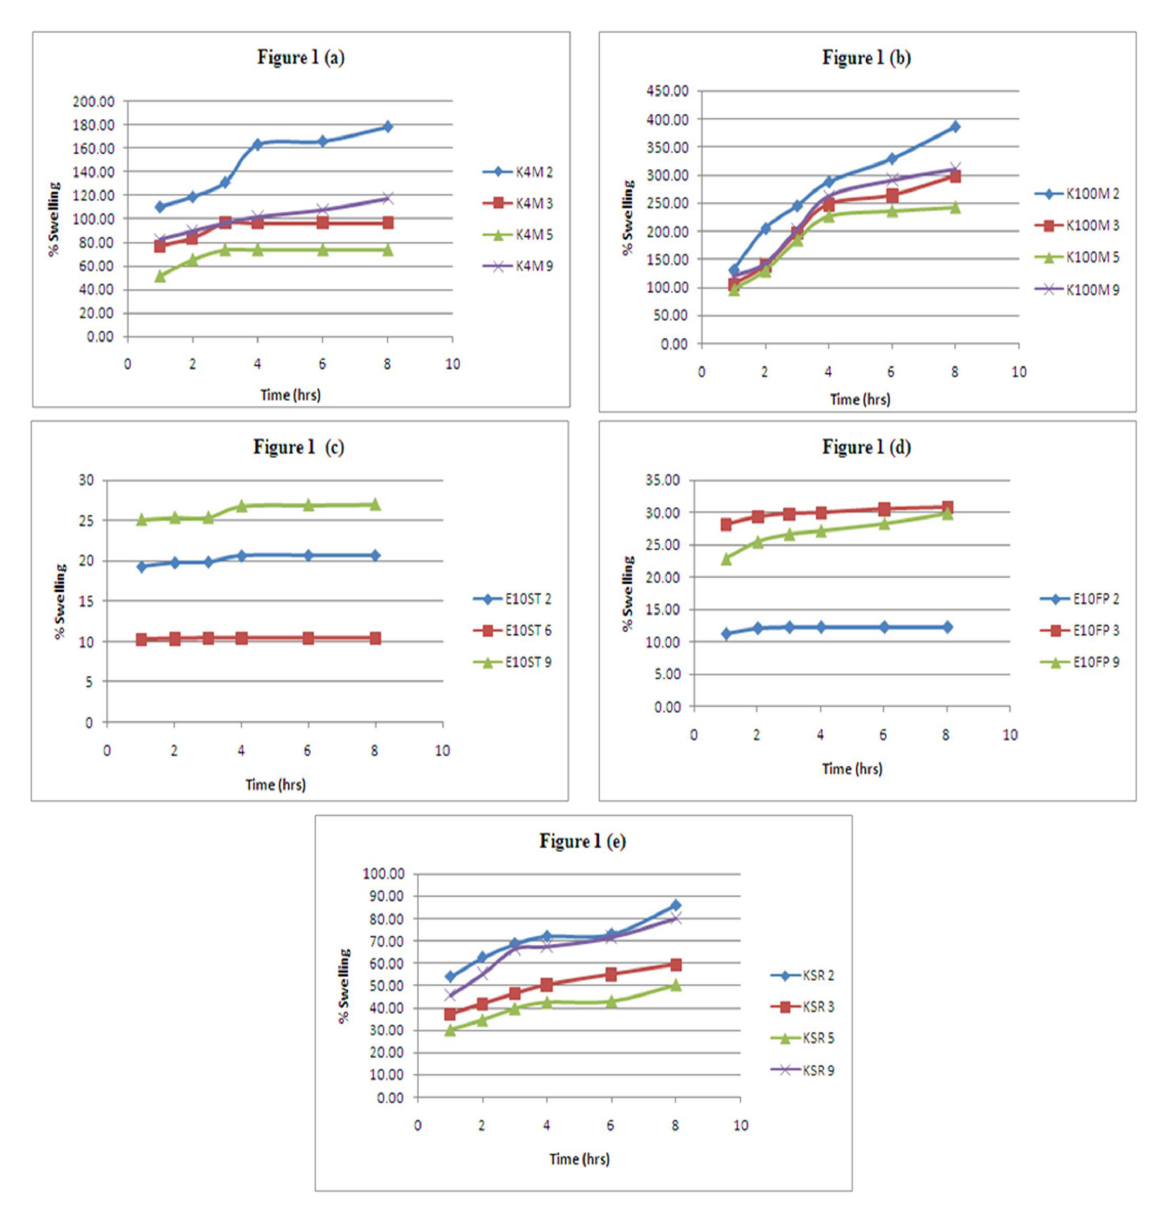
FIGURE 1 - Hydration behavior of tizanidine matrix formulations containing (a) HPMC K4M (b) HPMC K100M (c) Ethocel 10ST (d) Ethocel 10 FP (e) Kollidon